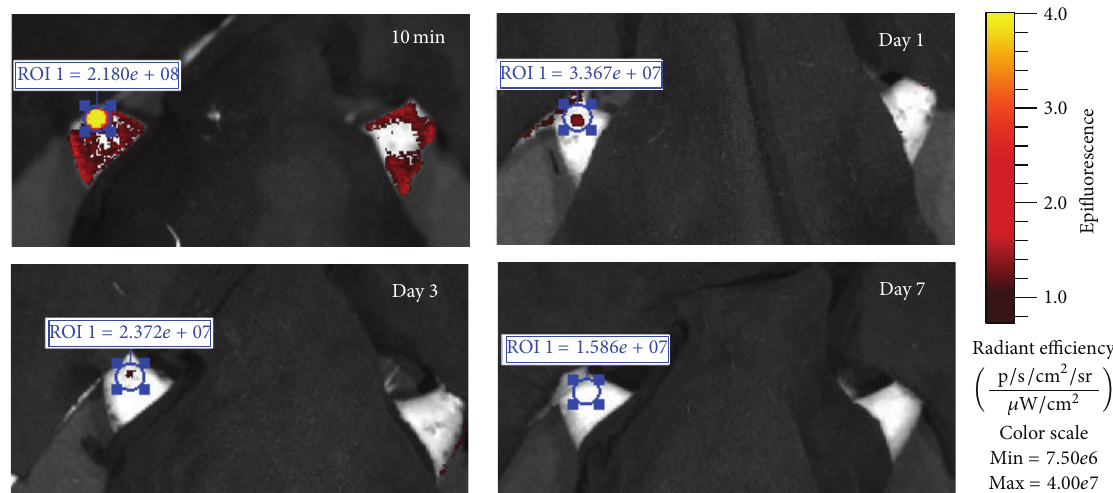
Figure 7: In vivo imaging of a representative animal in subsequent time points. 2.5 × 10 5 DiD-labeled MDCs were injected into the gastrocnemius muscle (limb on the left). Contralateral limb was injected with the equal volume of vehicle and constituted internal control. Optical imaging was carried out at 10min, days 1, 3, and 7 after the injection. Read-out scale was unified between the subsequent images, as presented on the right panel. Values in blue rectangles indicate total radiant efficiency of DiD-derived signal measured in subsequent time points in equal regions of interest